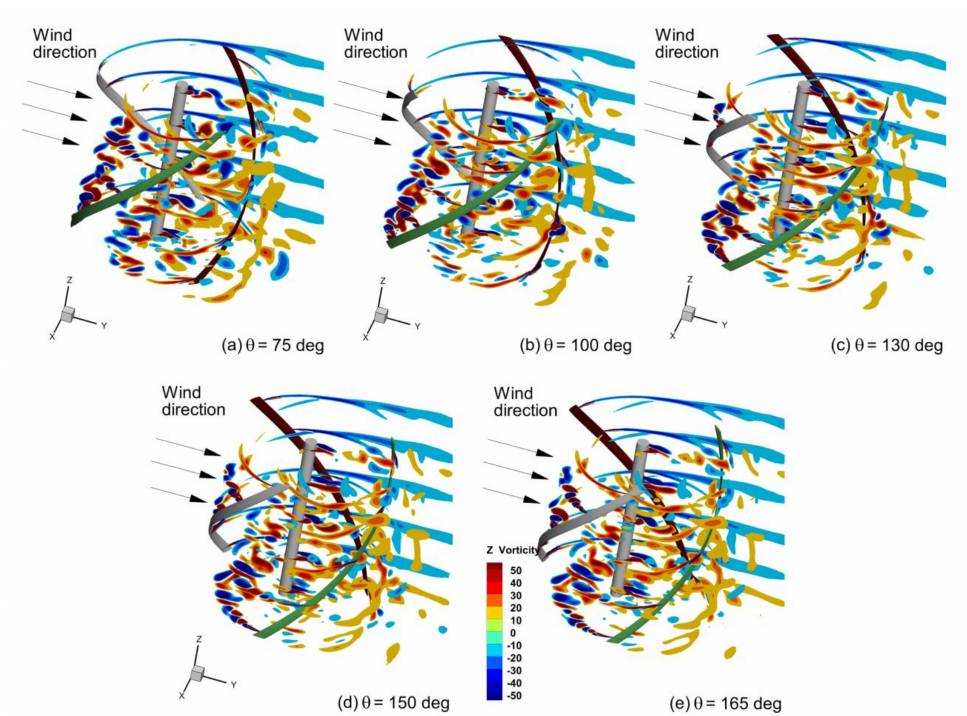
Figure 19. Z-vortex magnitude for 120 ◦ helical VAWT at z planes at heights of − 1.45 m, − 0.75 m, 0 m, 0.75 m, and 1.45 m at azimuth angles of rotation of ( a ) 75 ◦ , ( b ) 100 ◦ , ( c ) 135 ◦ , ( d ) 150 ◦ , and ( e ) 165 ◦